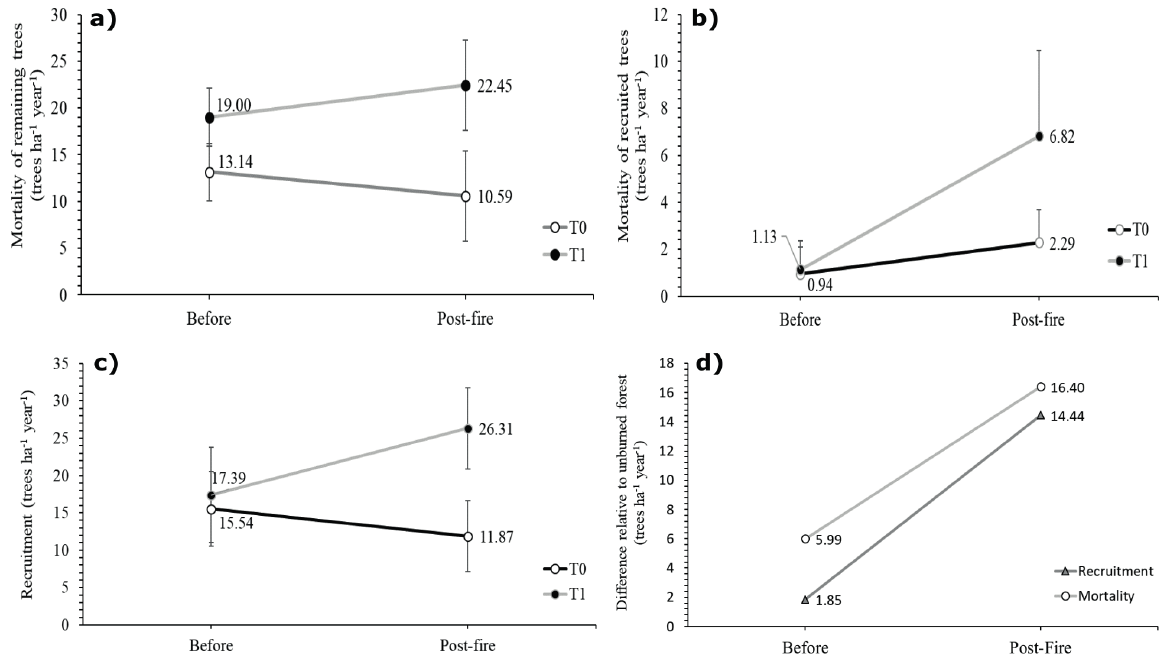
Figure 2 - Annual mortality rate (trees ha -1 year -1 ) for remaining trees ( a ) and trees recruited ( b ), annual recruitment rate (trees ha -1 year -1 ) and ( c ) the difference between the mortality and recruitment rates recorded for T0 (1.75 ha) and T1 (1.25 ha), before and after fire ( d ), considering trees with DBH ≥ 5 cm, monitored during 29 years in an area of dense ombrophylous forest with no logging history in the Floresta Nacional do Tapajós, Pará State, Brazil.